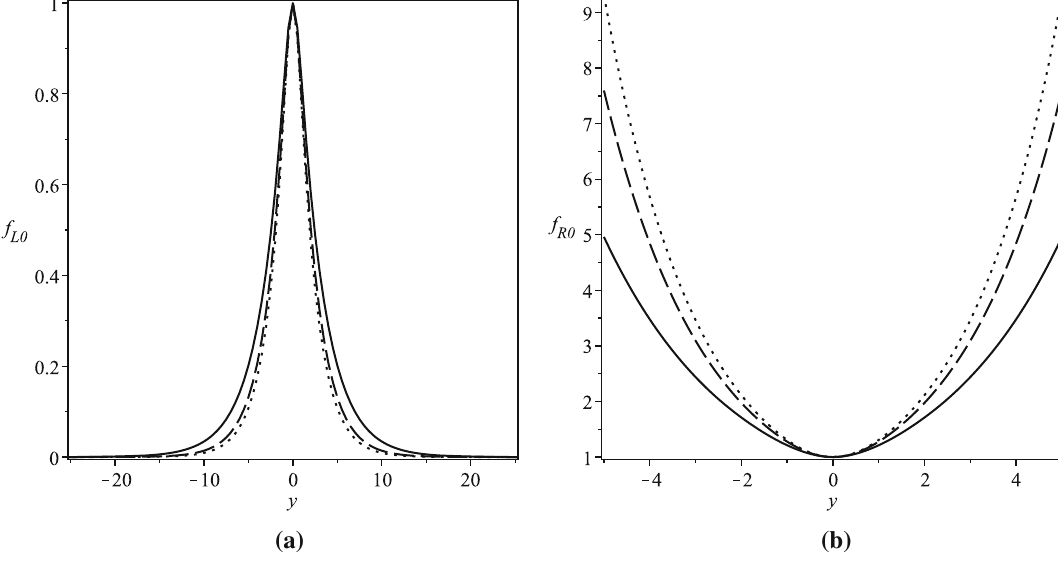
Fig. 10 The profile of a the left-handed zero mode and b the right-handed zero mode for a = 1 (solid line), a = 2 (dashed line), a = 5 (dotted line), η =